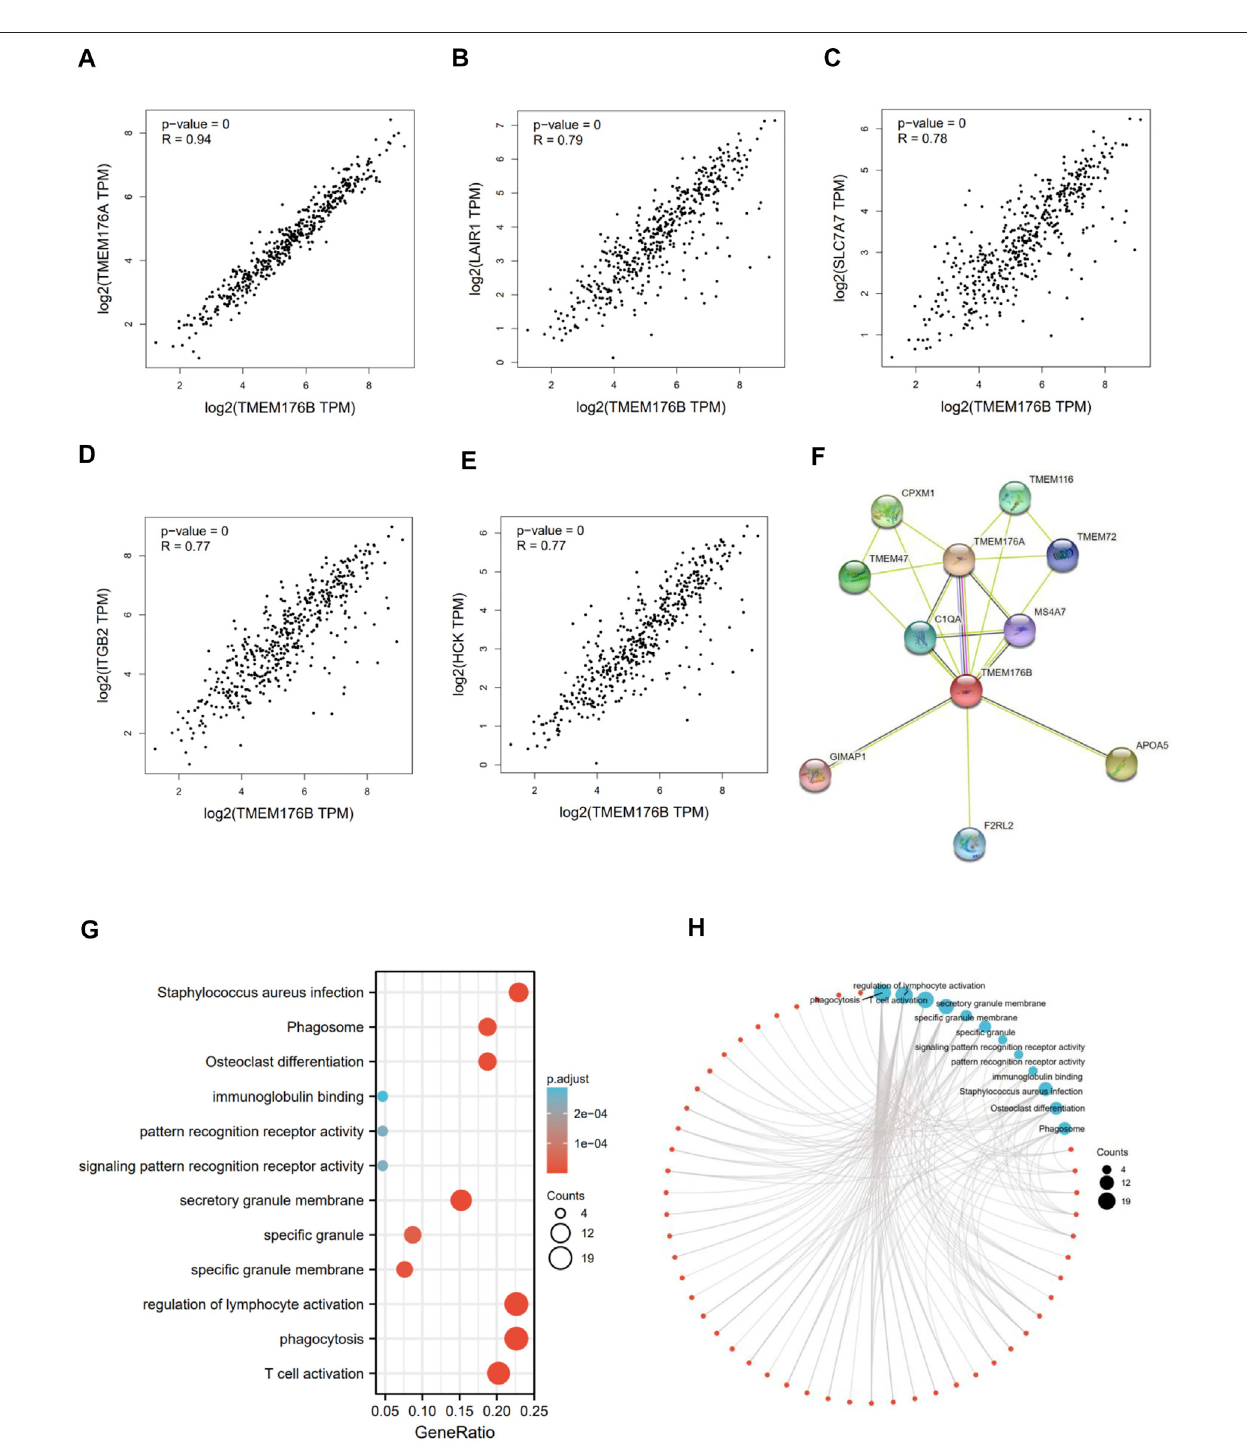
FIGURE3| TMEM176B-related geneenrichmentanalysis. (A – E) Using GEPIA2, weidenti fi edthe top100genesrelated with TMEM176B inSKCM and examined the expression connection between TMEM176B and fi ve genes, including TMEM176A , LAIR1 , SLC7A7 , ITGB2 , and HCK . (F) Protein networks that may interact with TMEM176B, data from STRING. (G,H) Enrichment analysis of TMEM176B -related genes.